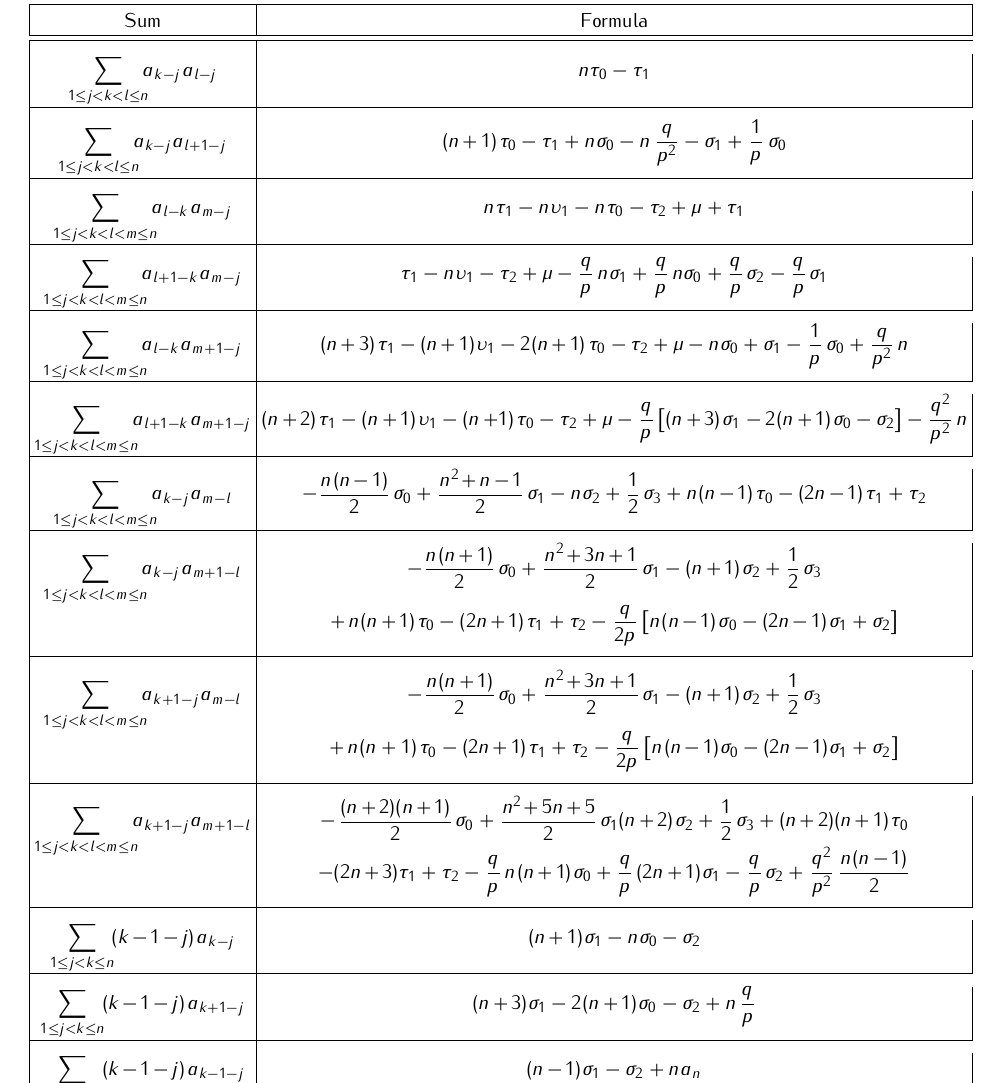
Table 1. The catalogue of